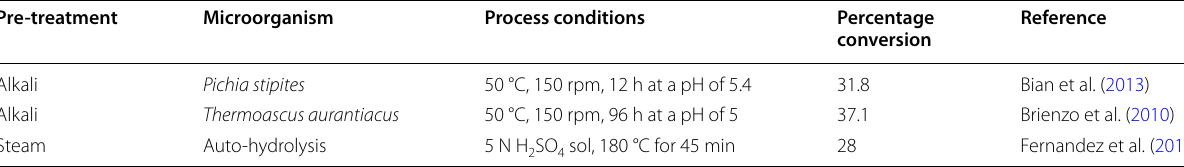
Table 7 Summary of oligosaccharides from SCB